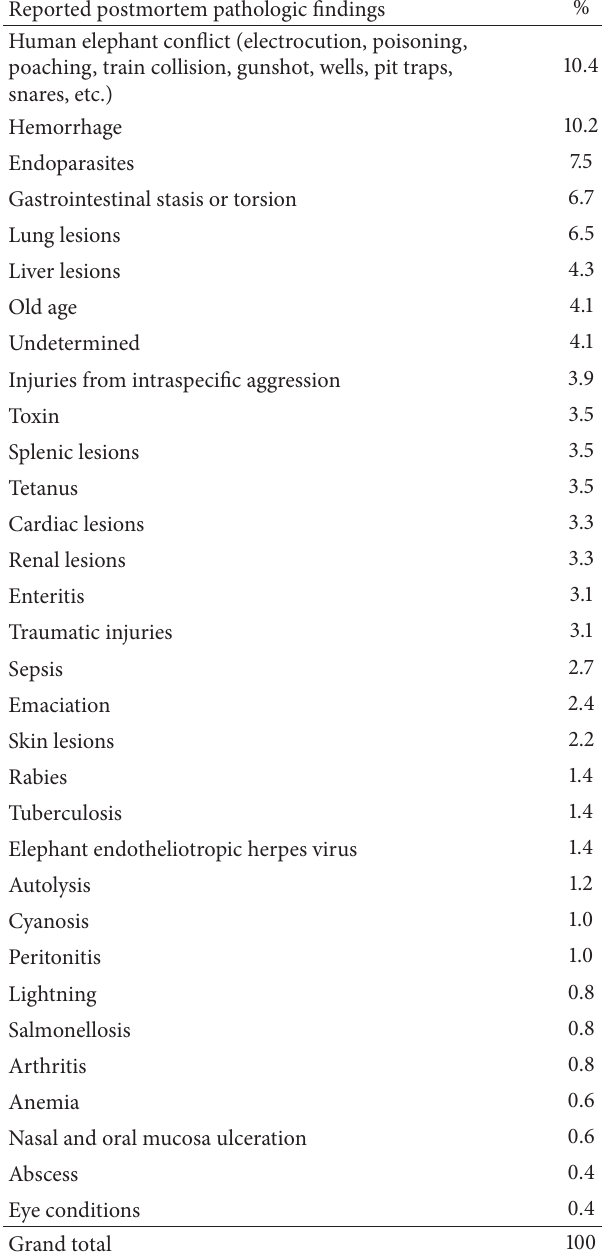
Table 3: Major postmortem pathologic findings reported by survey